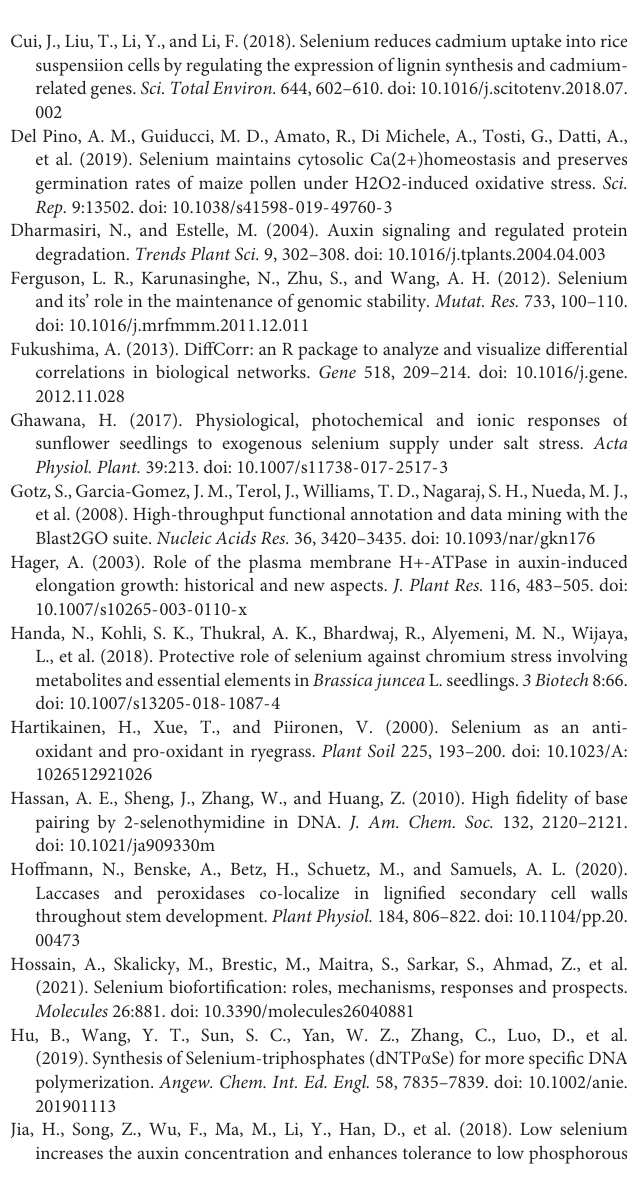
Supplementary Figure 1 | A flowchart for plant